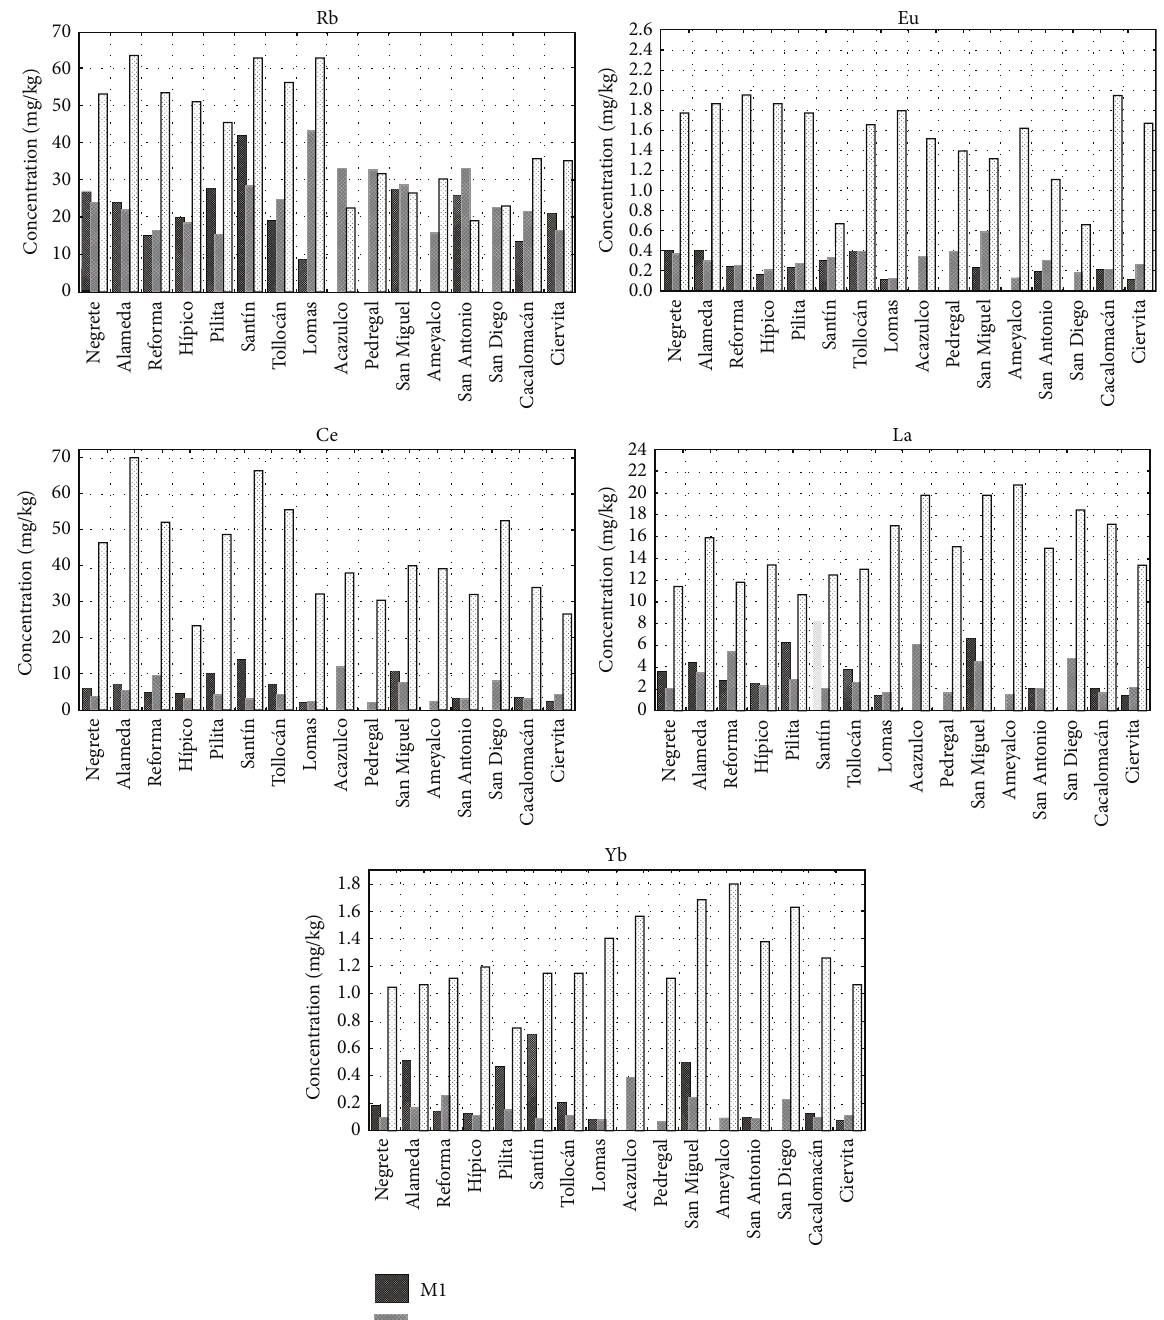
Figure 2: Element concentrations (mg kg −1 ) in moss and soil samples. M1 (moss autumn), M2 (moss summer), and S: soil.